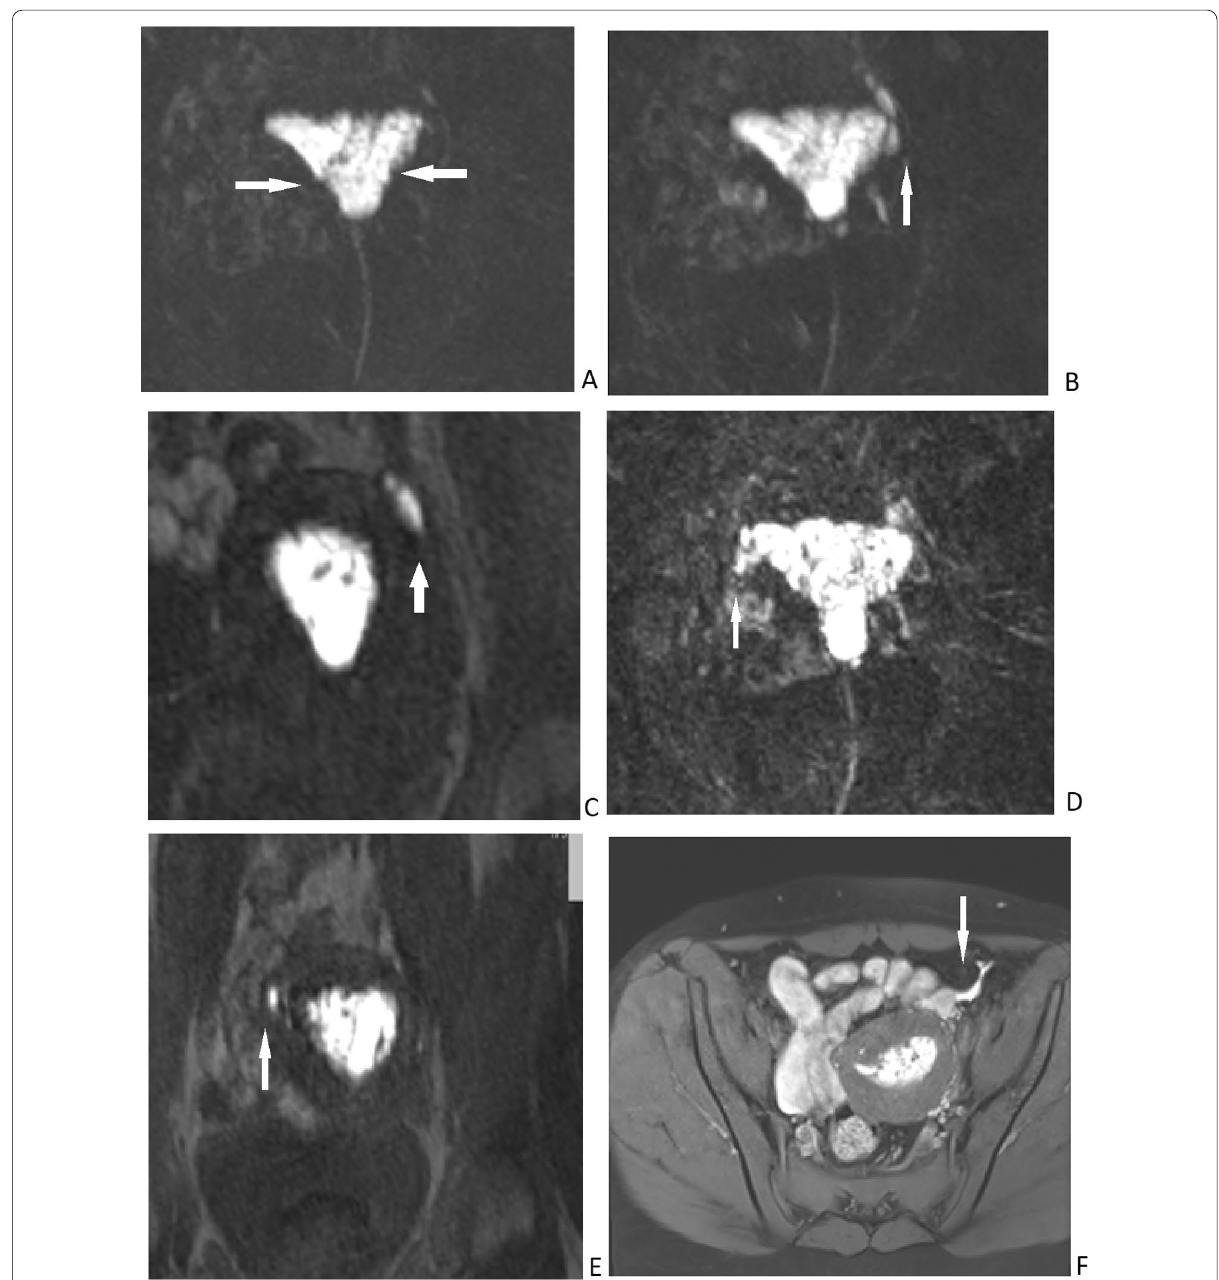
Fig. 7 Thirty-year-old female evaluated for primary infertility. Subtracted dynamic 3D T1 W angiographic series showing irregular endometrial contour (arrows) ( A ). Subsequent images reveal contrast in left (arrow) ( B , C ) and right (arrow) ( D , E ) fallopian tubes. On postcontrast fat sat T1 weighted axial image, bilateral tubal spill (white arrowheads) noted with thickened endometrium (arrow) ( F ). Case of